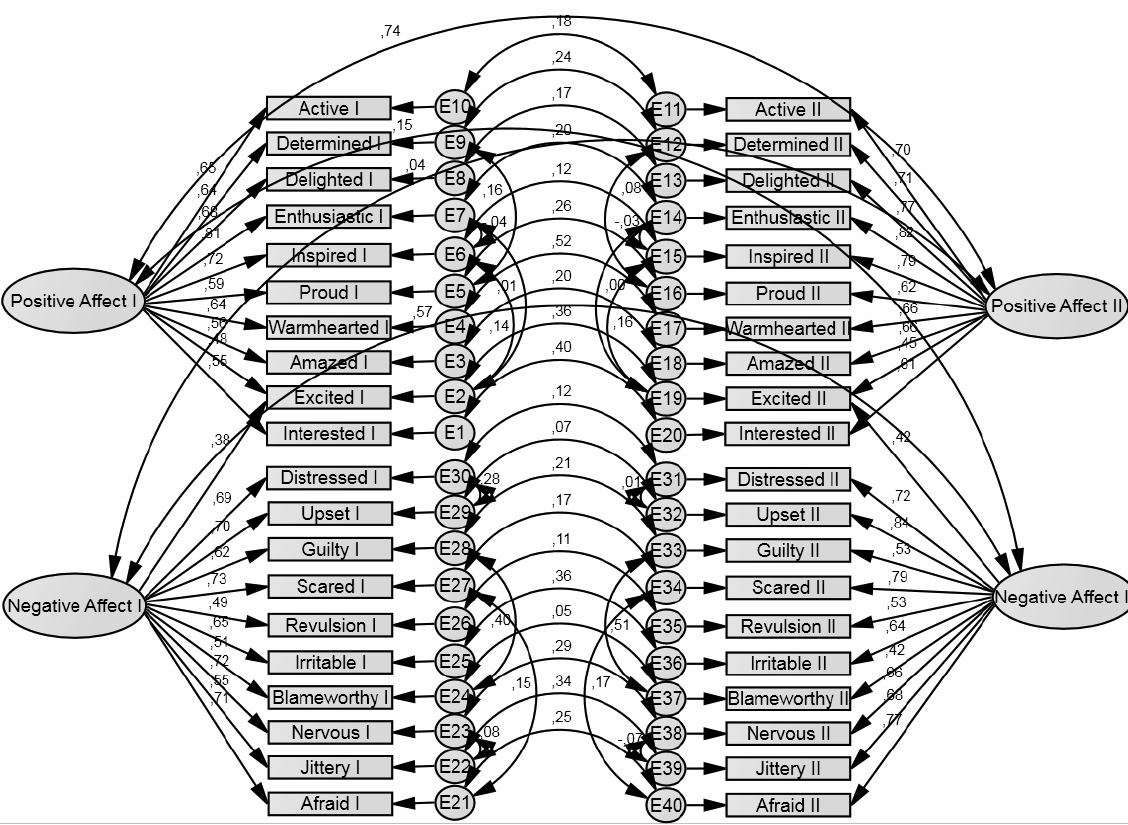
Figure 3 . Temporal Stability of the